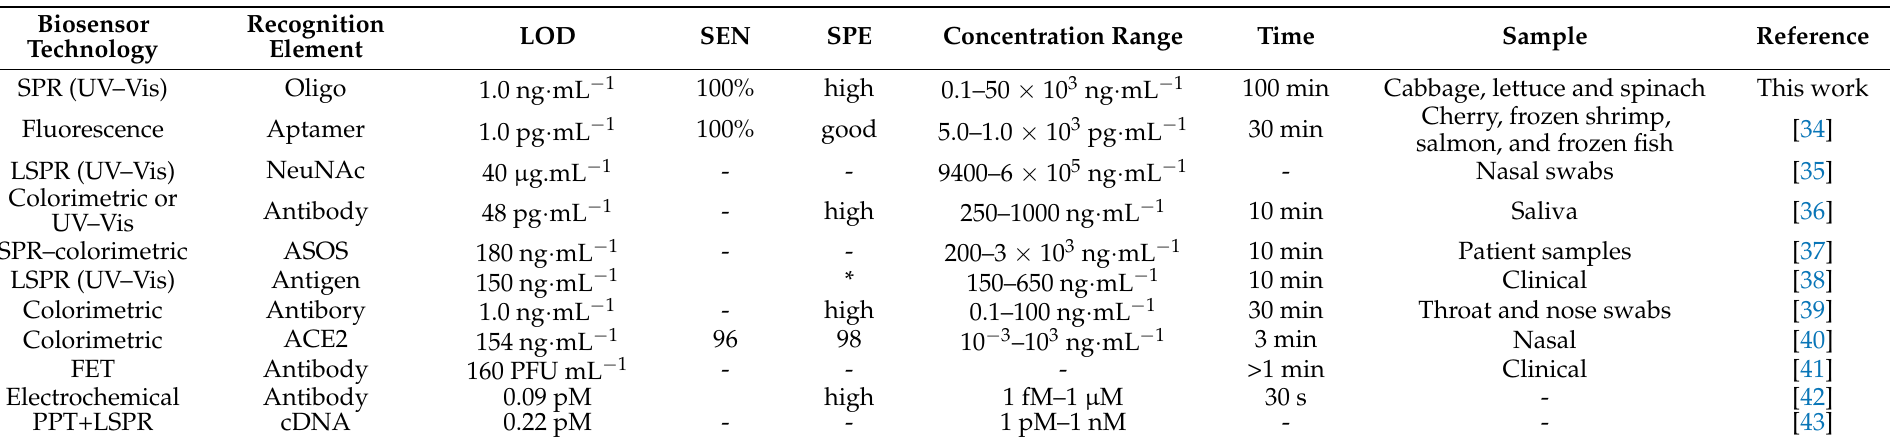
Table 2. Developed biosensors for detection of SARS-CoV-2 in several real